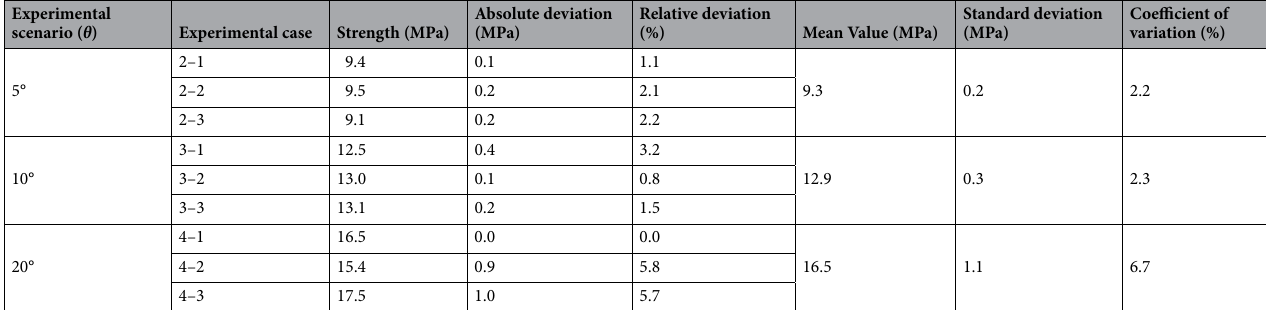
Table 2. Peak shear strength of granite specimens at different inclination angles (peak shear strength was equal to zero at an inclination angle of 0°).